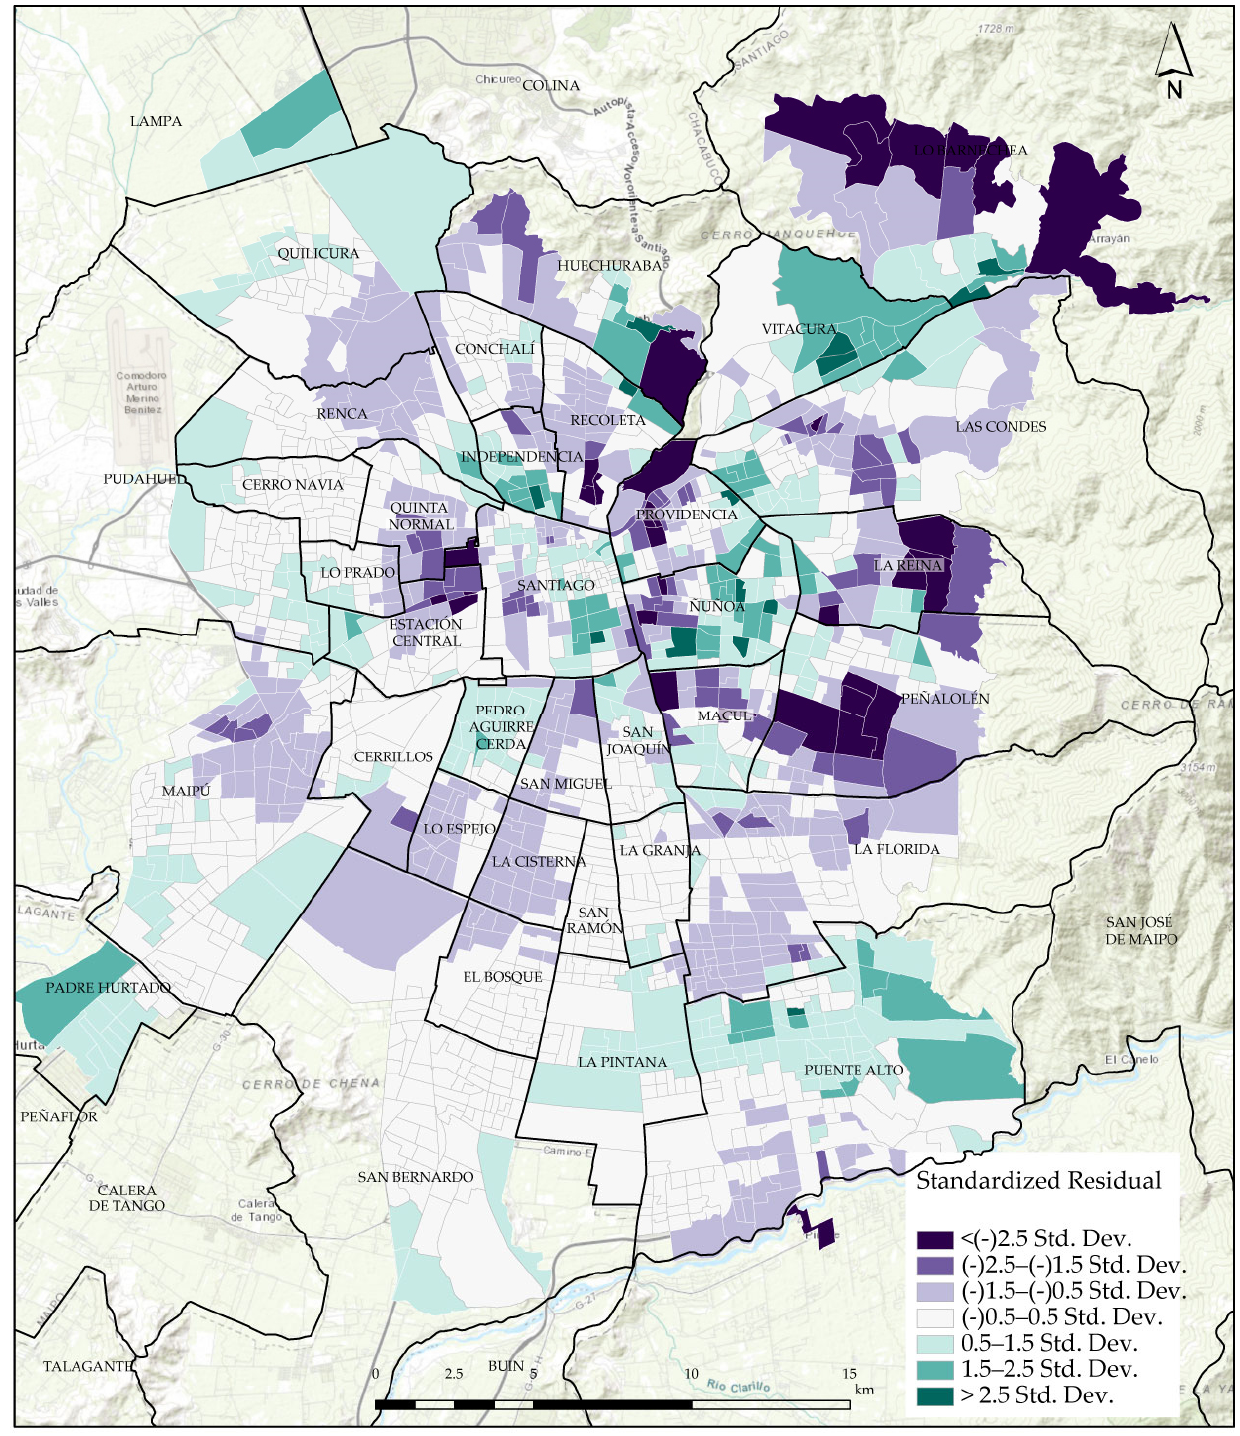
Figure 7. Standardized residuals for the GWR model by census tract unit.